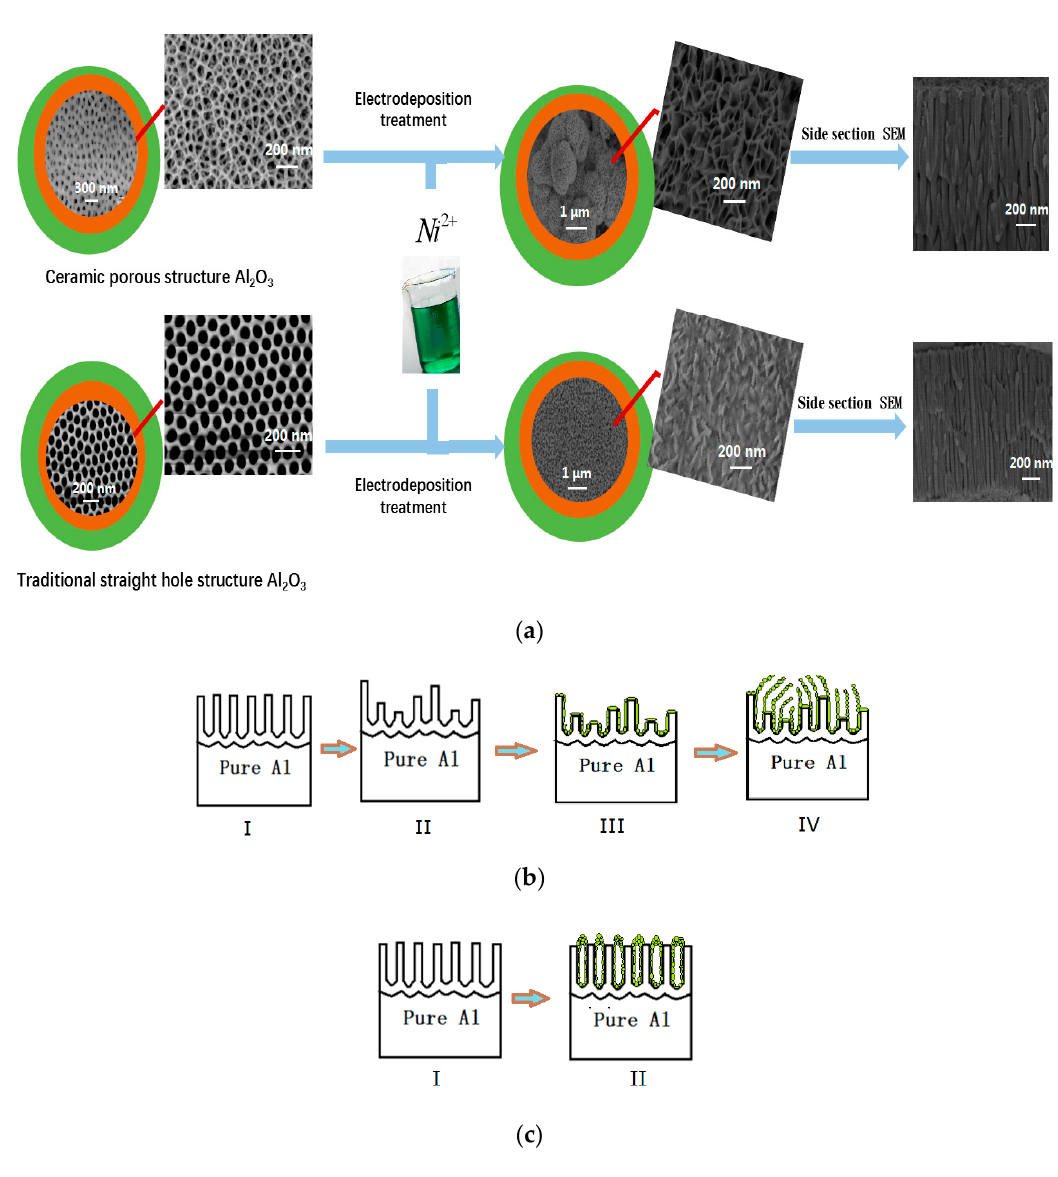
Figure 2. ( a ) Diagram of preparation process of Ni/Al 2 O 3 /Ni composite films; ( b , c ) growth mechanism of two kinds of Ni/Al 2 O 3 /Ni composite films.